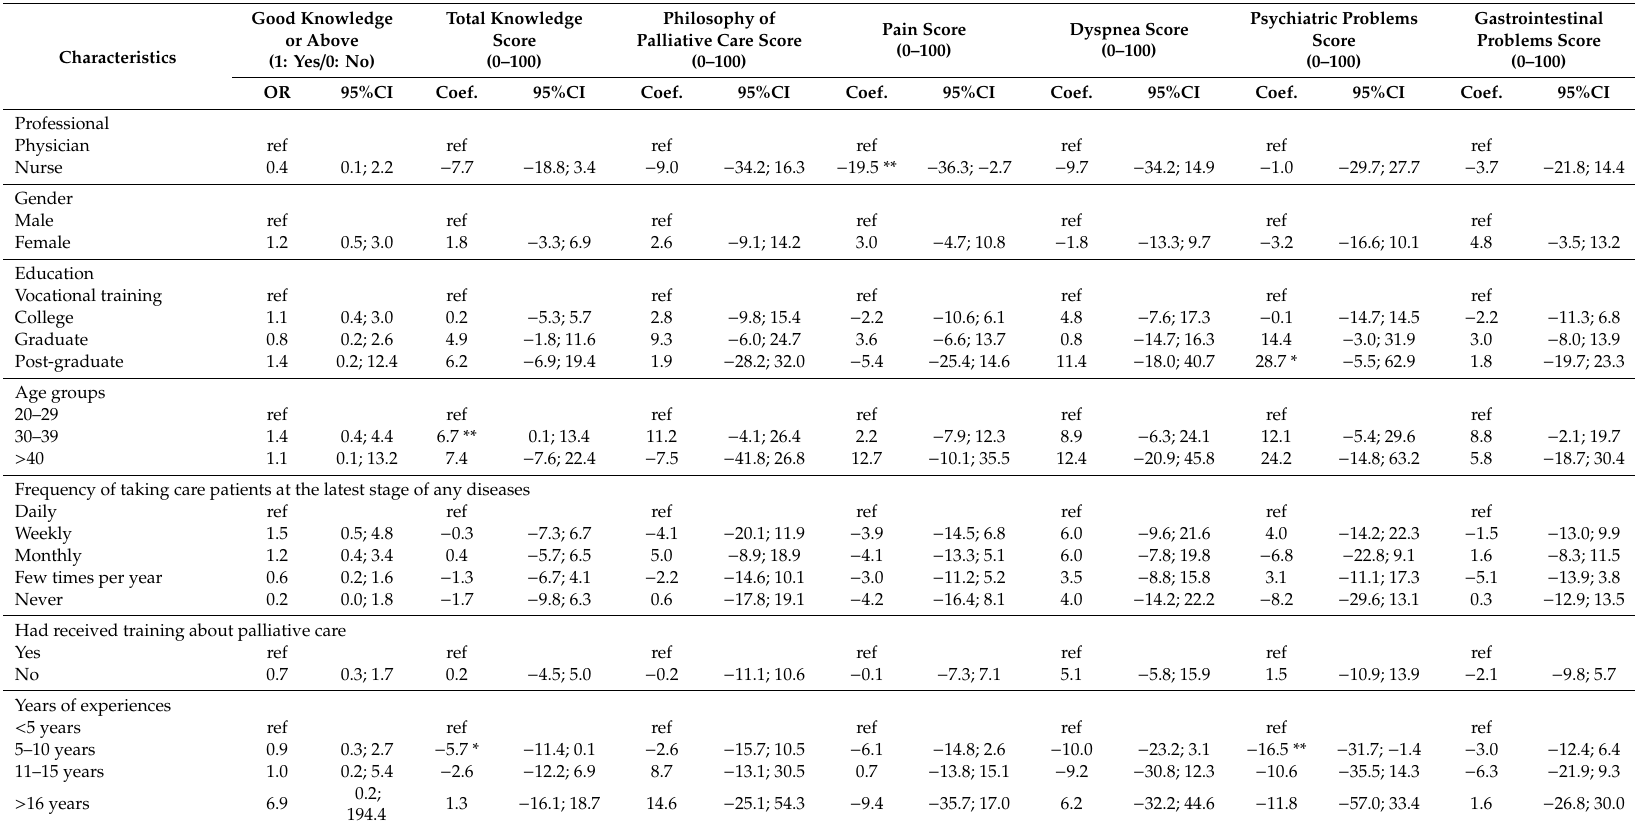
Table 4. Associated factors with knowledge about palliative